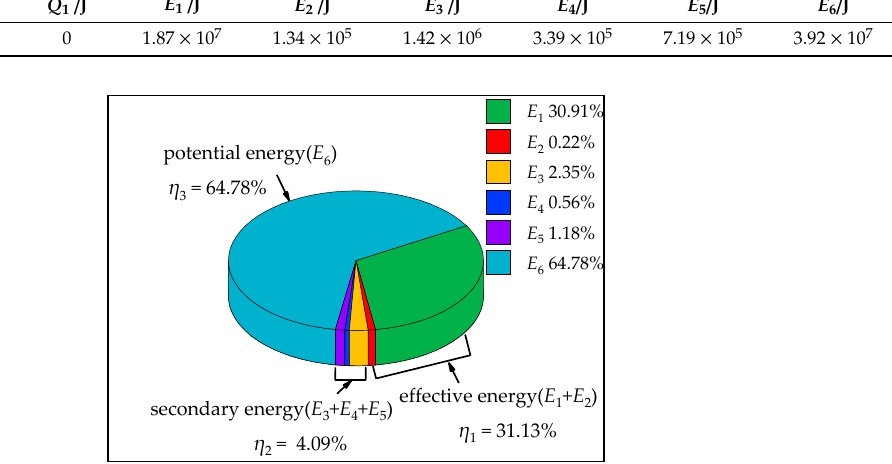
Table 4. Energy values at 18.9 ms.